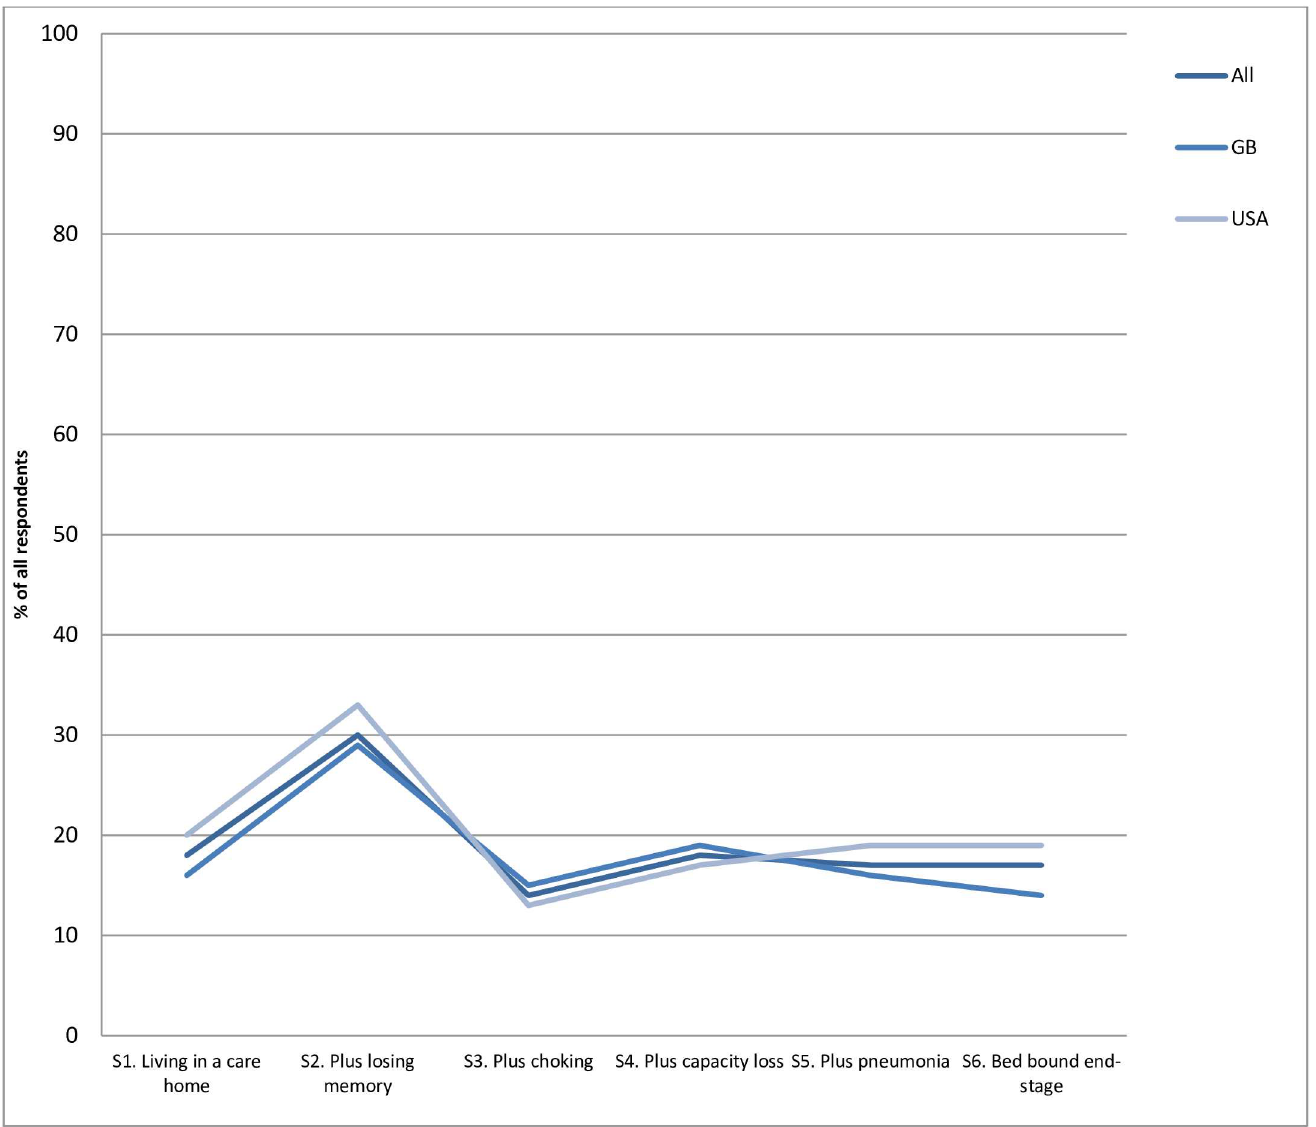
Fig 2. Percentage of respondents choosing maintain life at any cost across six stages (N =